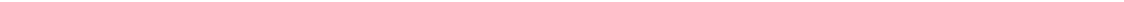
Fig. 3 Over-expression of Dkk3 in vivo induced muscle atrophy in young mice. a The schedule of virus injection. b Adenovirus-encoding Flag-Dkk3-IRES- GFP was injected to TA muscles in young mice (3 months) intramuscularly. Adenovirus-encoding GFP vector was injected to the TA muscle in mice with the same age and gender. Injections were performed once a day for 7 continuous days. TA muscles were harvested at day 14 for further analysis. A small portion of the TA muscles was used to make protein extracts. Anti-Flag immunoblotting was performed to detect the expression of the ectopic Flag- Dkk3 . c Immuno fl uorescent staining images of muscle cross sections derived from TA muscles over-expressing Dkk3 or vector control. Red indicated laminin staining; green indicated GFP; DAPI indicated nuclei; merge indicated merged images of laminin, GFP, and DAPI. Scale bars, 50 μ m. d Percentage distribution of muscle fi ber cross section area derived from muscles over-expressing Dkk3 or GFP. The cross areas of all 1500 fi bers in each TA muscle were checked. Black squares indicated muscle sections with ectopic Dkk3 expression. Gray dots indicated muscle sections expressing vector. Error bars indicated s.d. and were based on fi ve independent experiments. e Fbxo32 and Trim63 mRNA levels were measured by RT-qPCR in TA muscles with ectopic Dkk3 or GFP expression. Error bars indicated s.d. and were based on fi ve independent experiments. ** indicated p < 0.01. f Weight of TA muscles over- expressing Dkk3 was compared to that expressing vector control. Error bars indicated s.d. and were based on fi ve independent experiments. ** indicated p < 0.01. fg Speci fi c titanic force of TA muscles over-expressing Dkk3 or vector control in young mice (3 months). Error bars indicated s.d. and were based on 5 independent experiments. ** indicated p < 0.01. h 1/2 relaxation time of TA muscles over-expressing Dkk3 or vector control in young mice (3